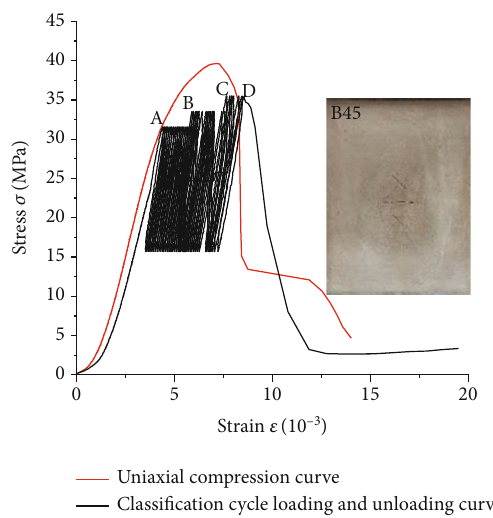
Figure 5: Stress – strain curves for the fractured sample under two loading modes.